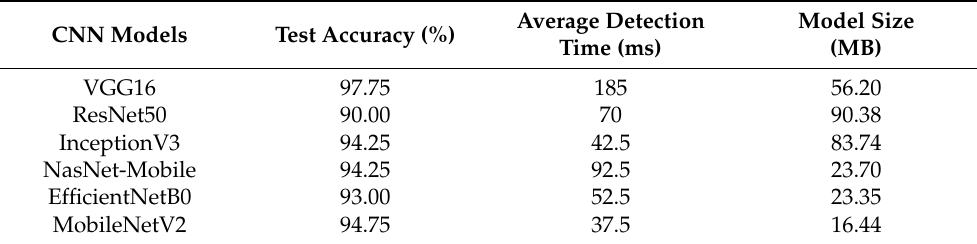
Table 2. The testing accuracy, average detection time, and model size of VGG16, ResNet50, Incep- tionV3, NasNet-Mobile, EfficientNetB0, and MobileNetV2. CNN Models